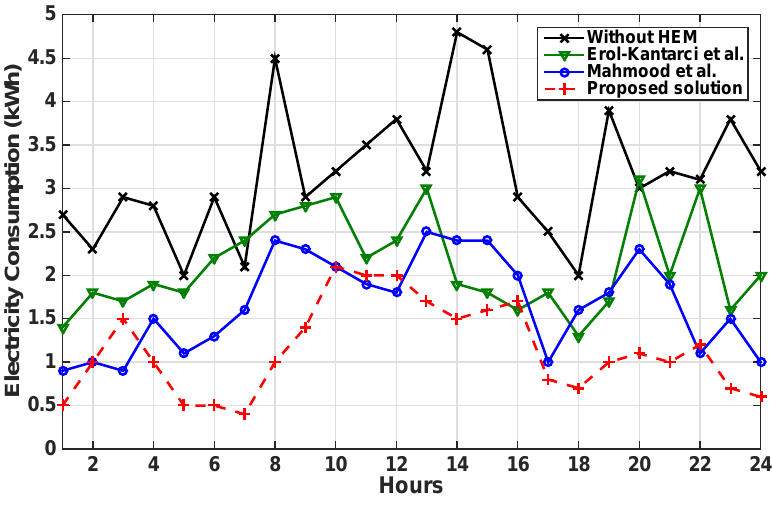
Figure 7. Peak load reduction